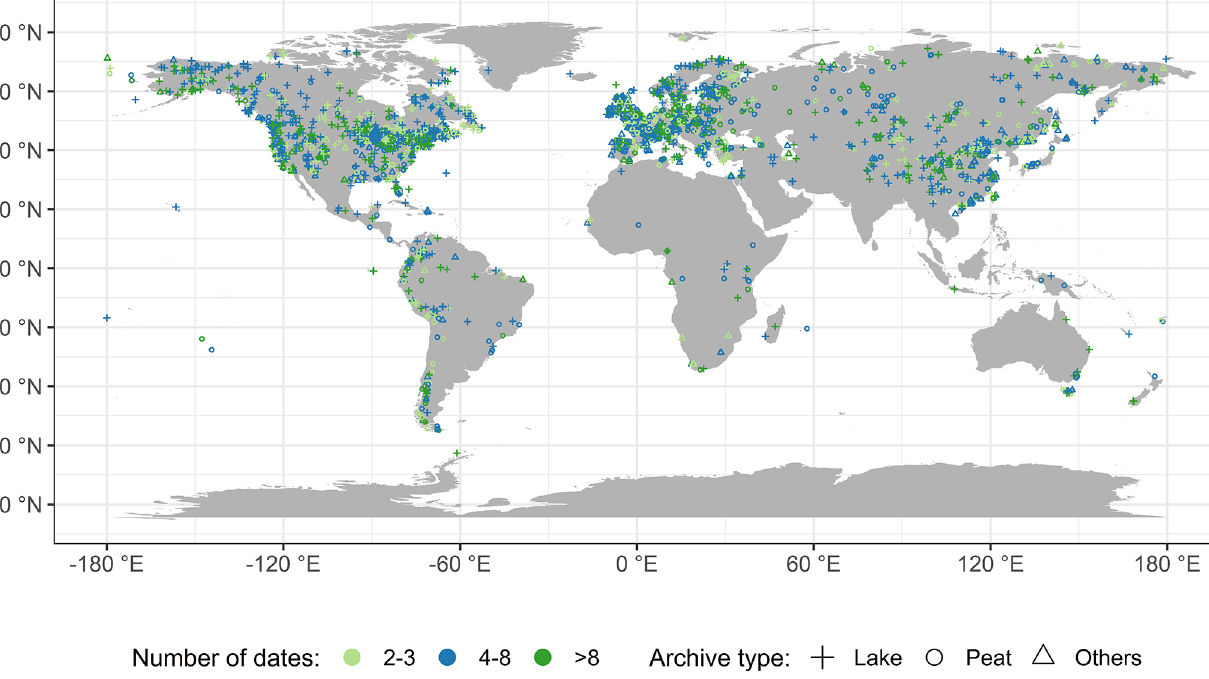
https://doi.org/10.5194/essd-14-1331-2022 Earth Syst. Sci. Data, 14, 1331–1343,